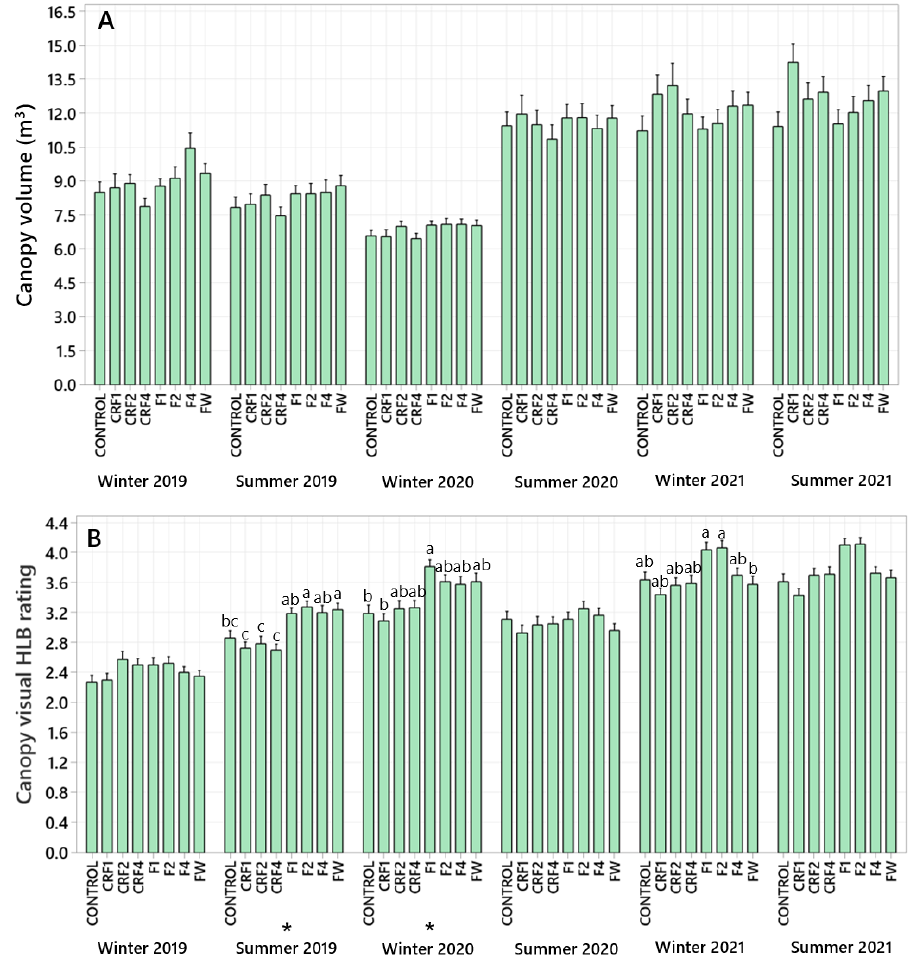
Figure 1. Canopy volume ( A ) and canopy visual huanglongbing (HLB) symptoms ( B ) measured from Winter 2019 to Summer 2021. Six-year-old HLB-affected ‘Ruby Red’ grapefruit trees grafted on sour orange rootstock were used. A one-way analysis of variance (ANOVA) with a Tukey honestly significant difference (HSD) test was used to determine significant differences between means. Letters indicate statistically significant differences ( p ≤ 0.05). Bars represents standard error. Asterisks (*) indicate differences between the means of all granular treatments vs. all liquid treatments determined using a linear contrast analysis.